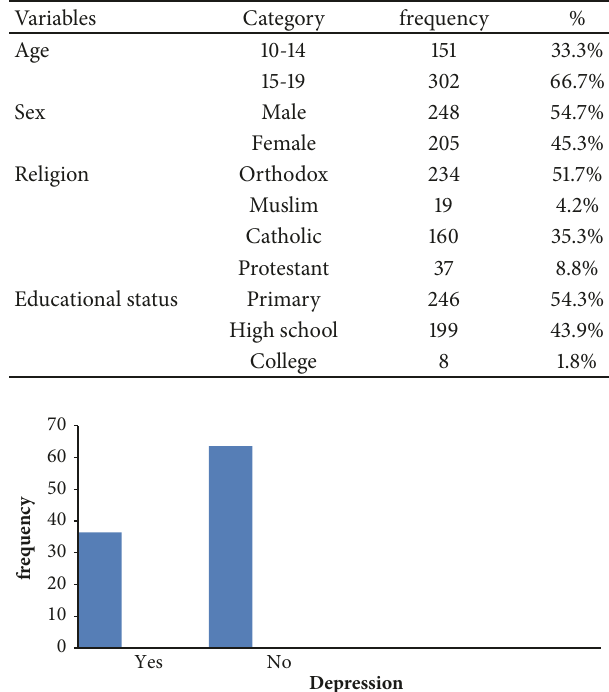
Figure 1: Prevalence of depression among orphan adolescent in Addis Ababa, Ethiopia, Jun